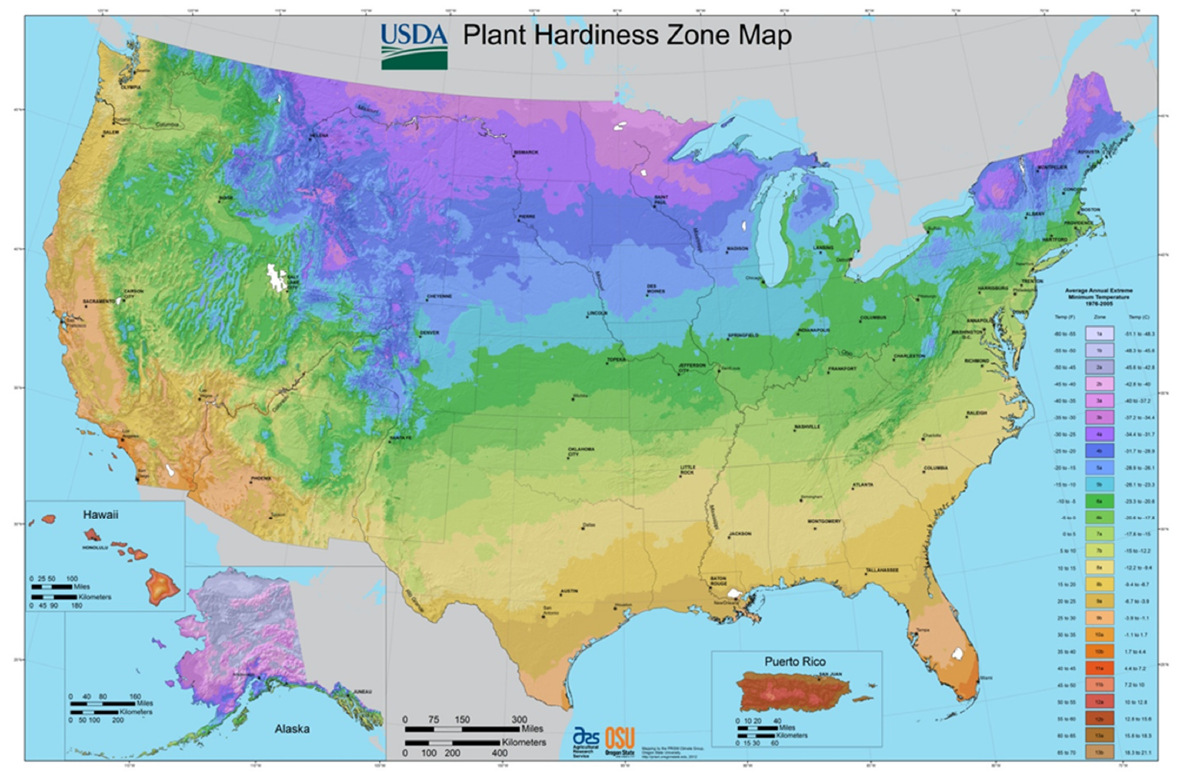
Figure 1. U.S. Department of Agriculture Plant Hardiness Zone Map. It is “the standard by which gardeners and growers can determine which plants are most likely to thrive at a location. This map is based on the average annual minimum winter temperature, divided into 10 °F zones” [32]. Table 1. Seven plant species evaluated as host candidates of crapemyrtle bark scale (CMBS).